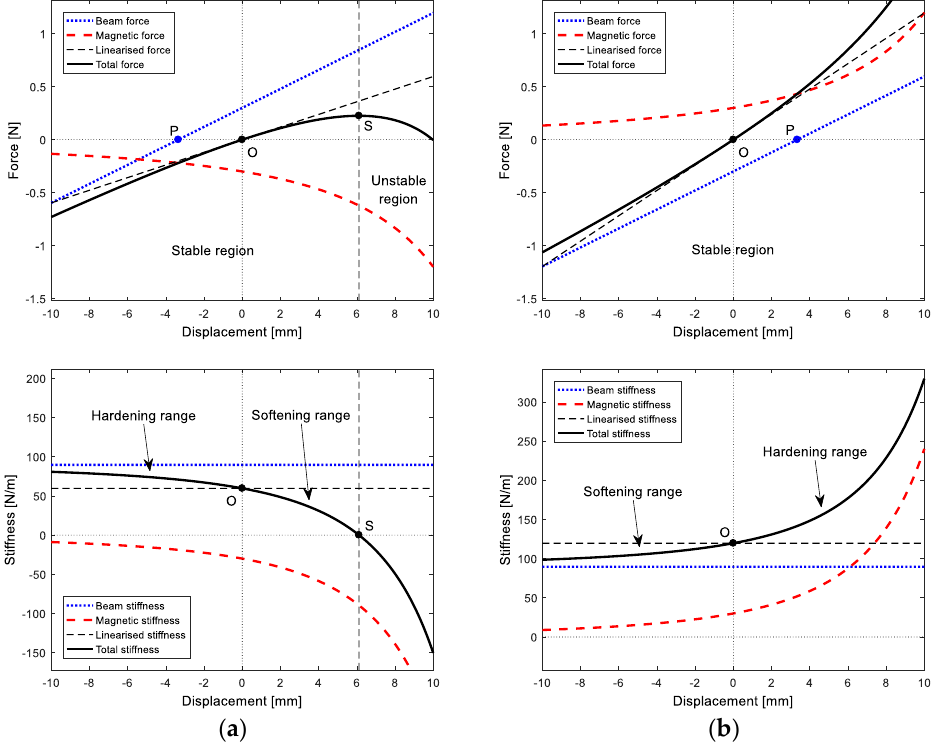
Figure 18. Effects on elastic restoring force and stiffness with magnets in attraction ( a ), or in repul- sion ( b